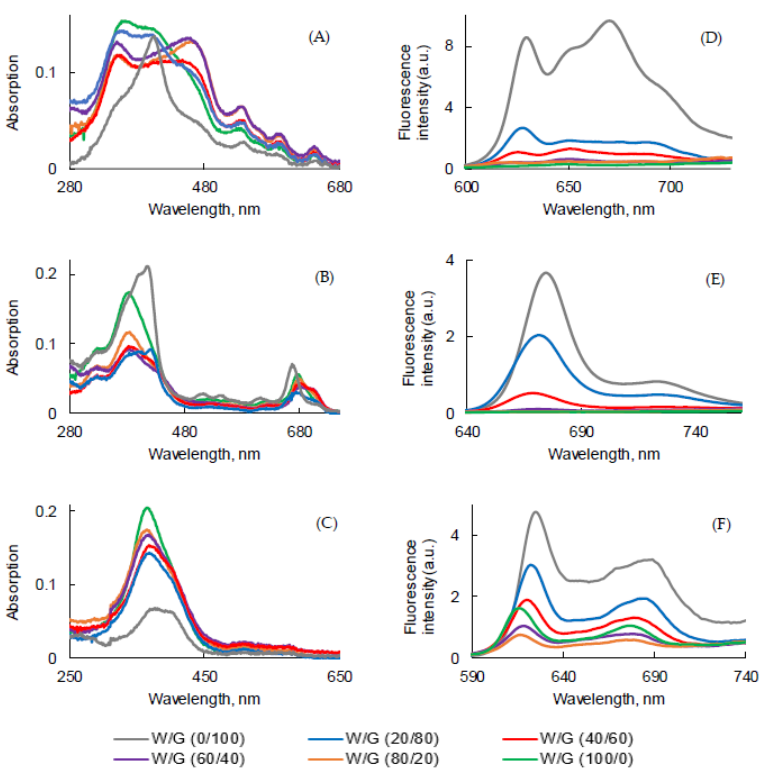
Figure 6. UV-visible absorption and fluorescence emission spectra (( λ exc = 400 nm for PpIX, PF and 415 nm for PPa) of PpIX ( A , D ), PPa ( B , E ), and PF ( C , F ) in water/glycerol (W/G) mixtures ( c = 3.1 µ M) at room temperature.